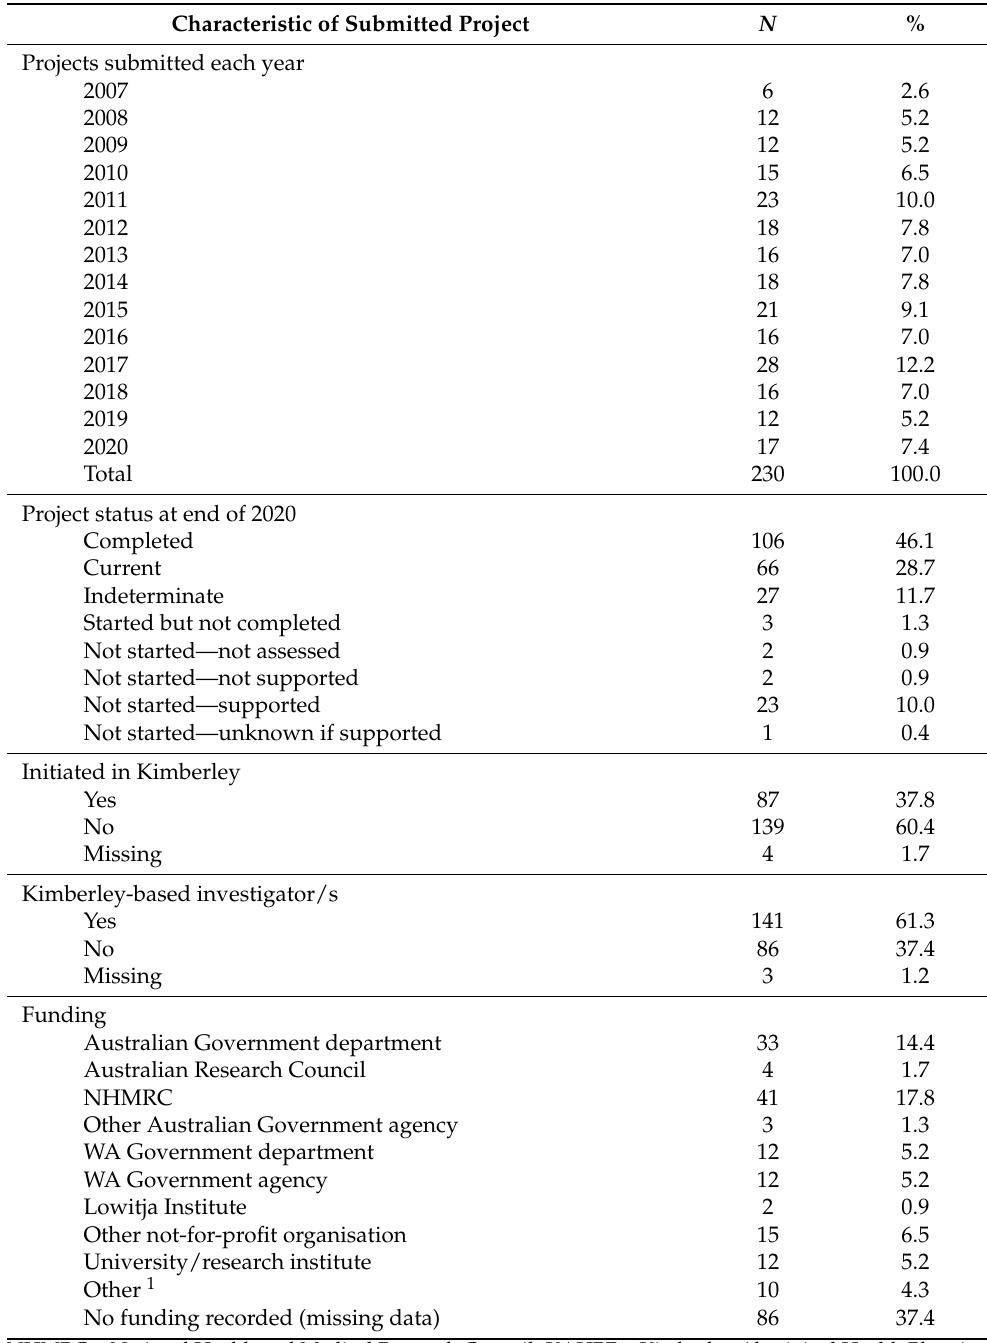
Table 1. Characteristics of projects submitted to the KAHPF Research Subcommittee until the end of